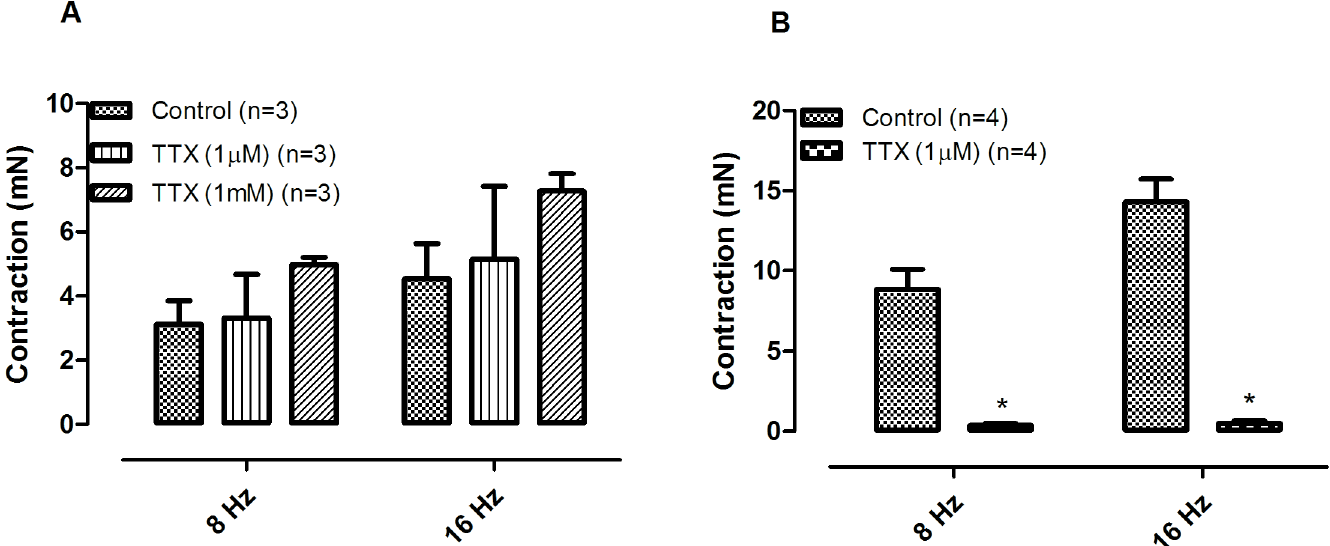
Fig 3. Effect of tetrodotoxin (1 μ M and 1mM) on EFS-inducedcontractions of corpora cavernosaisolated from Crotalus (A) and rabbit (B) . Data are expressedas mean ± standarderror mean (S.E.M) pairedStudent’st test, * P < 0.05 vs control.